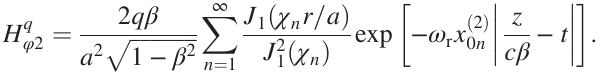
FIG. 2. Singularities, branch cuts, and integration paths in the complex plane of ω for the field components in a